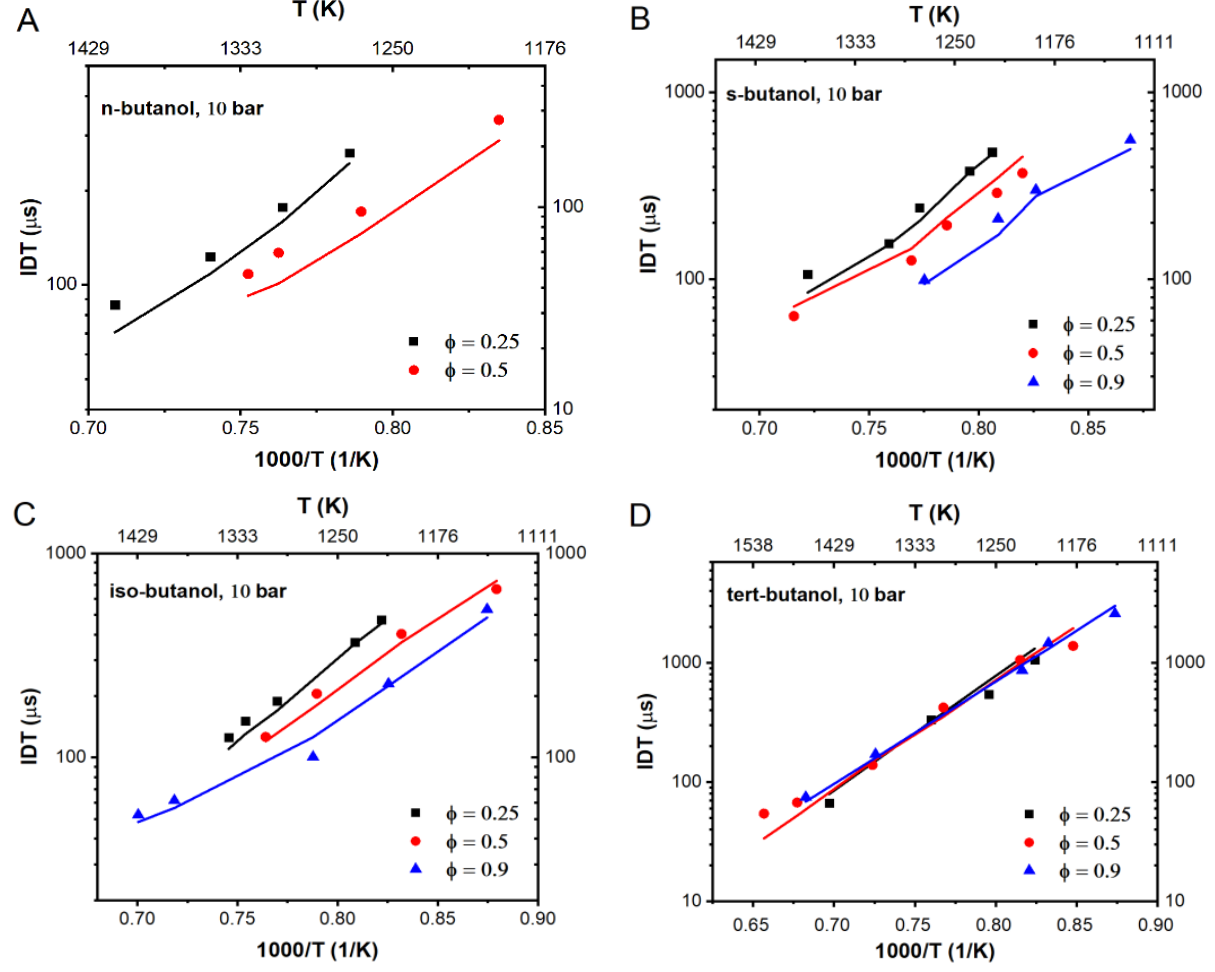
Figure 9. IDTs of ( A ) n-butanol, ( B ) sec-butanol, ( C ) iso-butanol, and ( D ) tert-butanol measured in the HPST at 10 bar and φ = 0.25, 0.5, and 0.9. (Symbols: experimental points; Lines: model predictions).